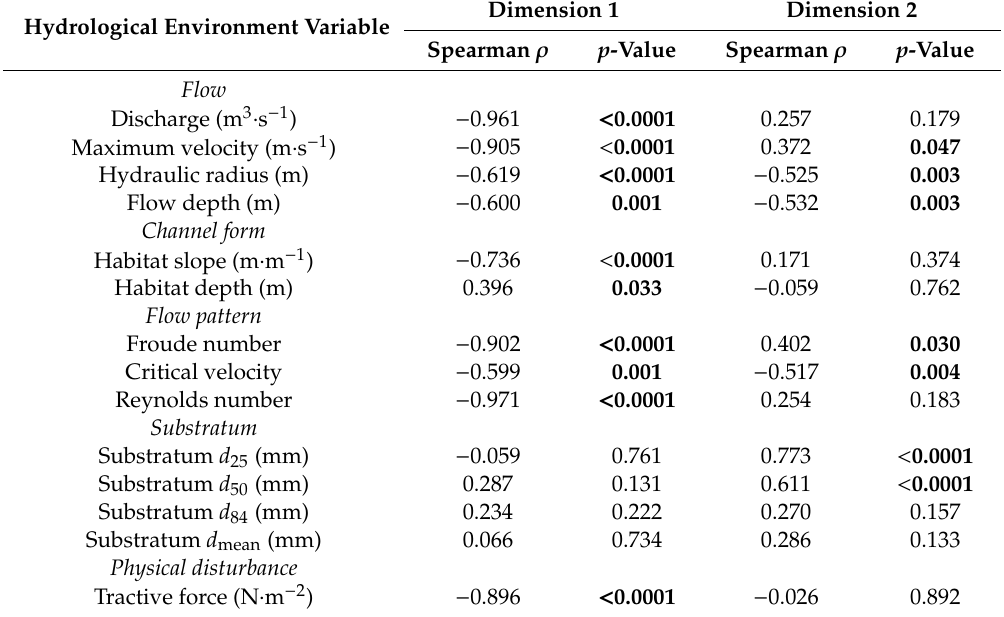
Table 2. Spearman ρ correlations of mean relativised hydrological environment variables with hydrological MDS dimension 1 and 2 scores. Bold text—significant at p <